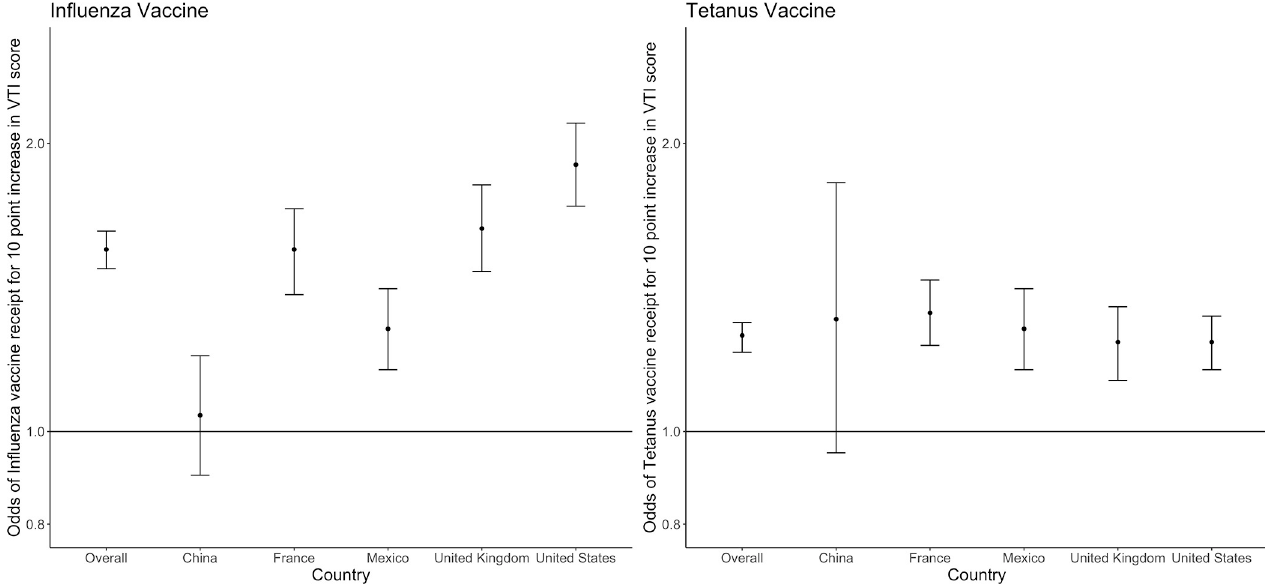
Fig 1. Odds of influenza and tetanus vaccine receipt for a ten-point increase in VTI score overall and by country.